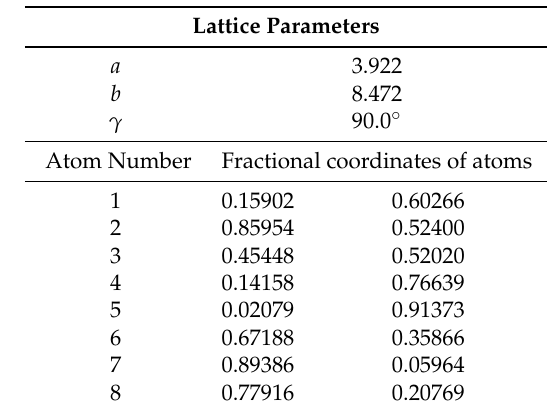
Table A3. Lattice parameters (Å) and fractional coordinates of atoms of initial cyclicgraphene - rP8 - P1-primitive cell